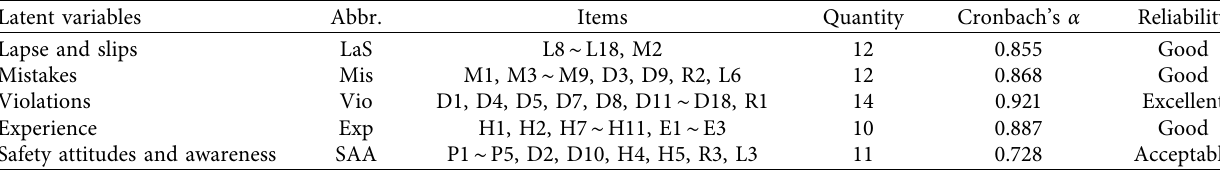
Table 4: Test results of adjusted latent variable reliability.